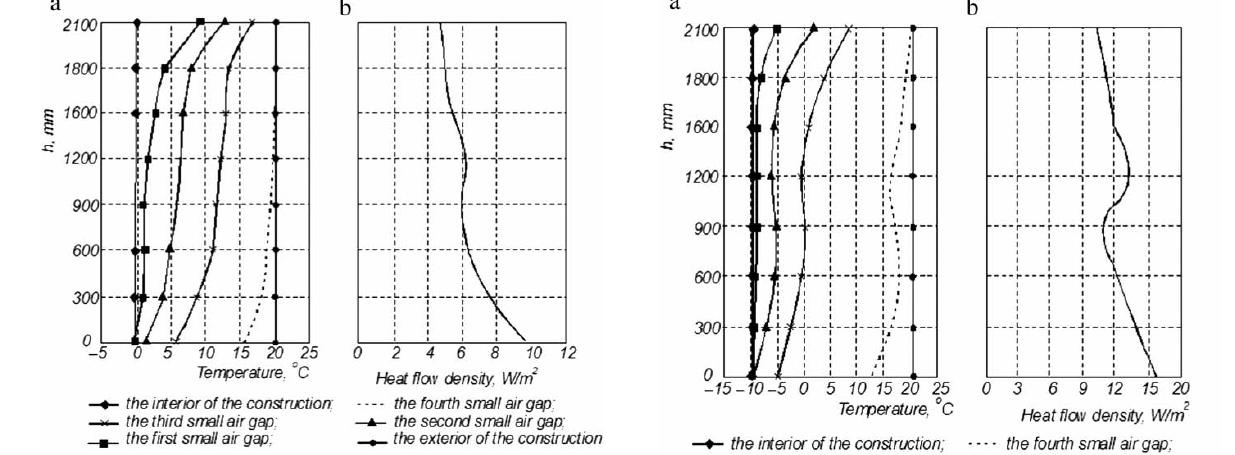
Table 2. Thermal-technical properties of thermal-insulating materials